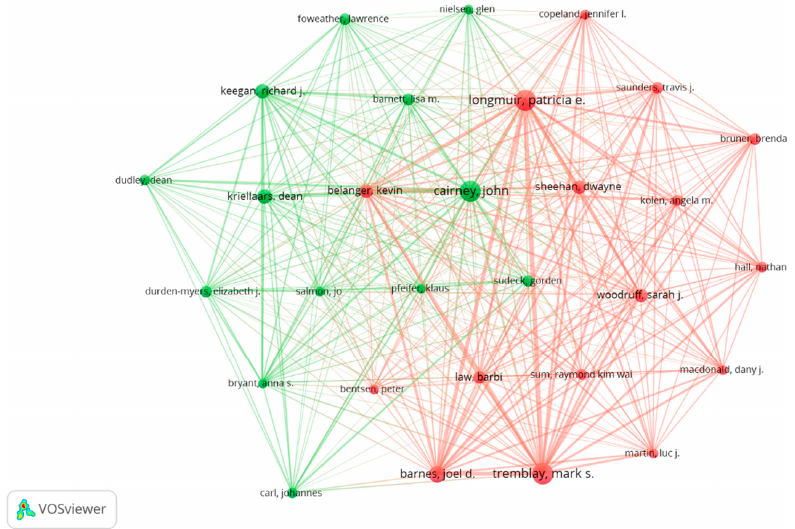
Figure 3. Co-authors graph on physical literacy (only prolific authors).